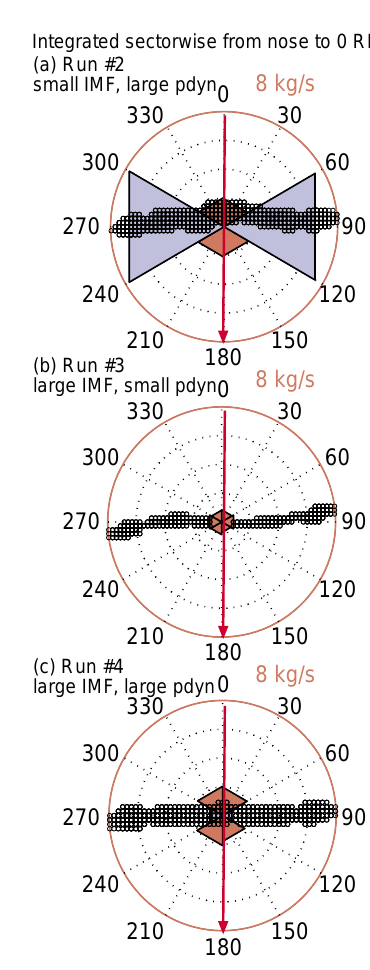
Fig. 9. (a–c) Instantaneous distributions of azimuthal mass trans- fer to dayside closed field for Run #2, #3, and #4, respectively, for due south IMF. Blue (red) color indicates towards closed (out from closed) field mass transfer in sectors shown outside the outer circle. The sectors scale from 0kgs − 1 at the centre to 8kgs − 1 at the outer circle. The IMF clock angle direction is indicated by a red arrow, while black circles show the locations where the “four-field junc- tion” condition holds; i.e., where reconnection is likely to